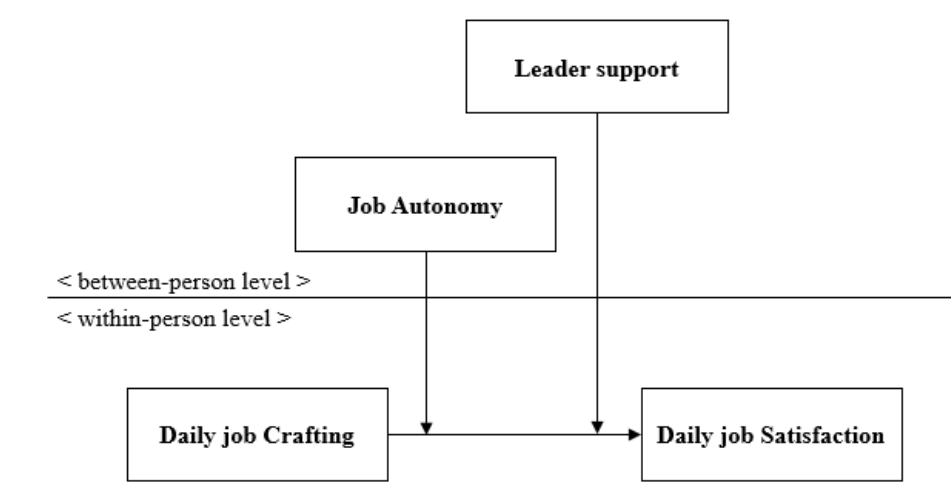
Figure 1. Proposed research model .